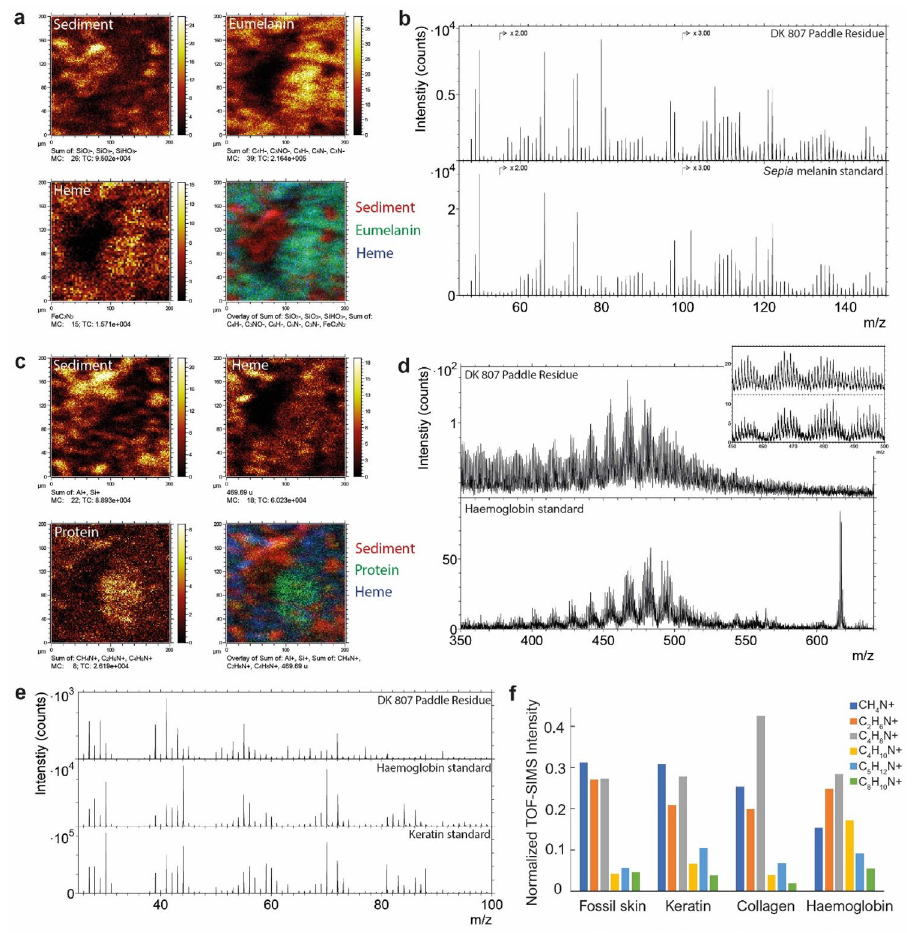
Figure 5. ToF-SIMS data obtained from the flipper residues in DK 807. ( a ) Negative-ion images showing the spatial distribution of ions representing sediment (SiO 2 − , SiO 3 − and SiHO 3 − ), eumelanin (C 4 H − , C 3 NO − , C 5 N − and C 3 N − ) and heme (FeC 2 N 2 − ), respectively. The last panel is a three-colour overlay of the preceding figures, where the sediment is depicted in red, eumelanin in green and heme in blue. ( b ) Negative-ion spectrum acquired from an area of the fossil soft tissue with prominent eumelanin signal compared against a Sepia eumelanin standard spectrum. ( c ) Positive-ion images of the same area as depicted in ( a ), showing the spatial distribution of ions representing sediment (Al + , Si + ), heme ( m/z 435–502), and proteinaceous matter (CH 4 N + , C 2 H 6 N + and C 4 H 8 N + ). The final panel is an overlay image in which the sediment occurs in red, proteinaceous matter in green and heme in blue. ( d ) Positive-ion spectra of heme-associated ions from the fossil sample compared against a haemoglobin standard. Note the undulating pattern in both spectra representing Fe-porphyrin fragment ions characteristic of heme. ( e ) Positive-ion spectrum from a region of the fossil tissue with prominent signal from nitrogen-containing ions indicative of proteinaceous matter compared against spectra of haemoglobin and keratin standards. ( f ) Normalized signal intensities of characteristic peptide/protein fragment ions in DK 807 together with relevant protein